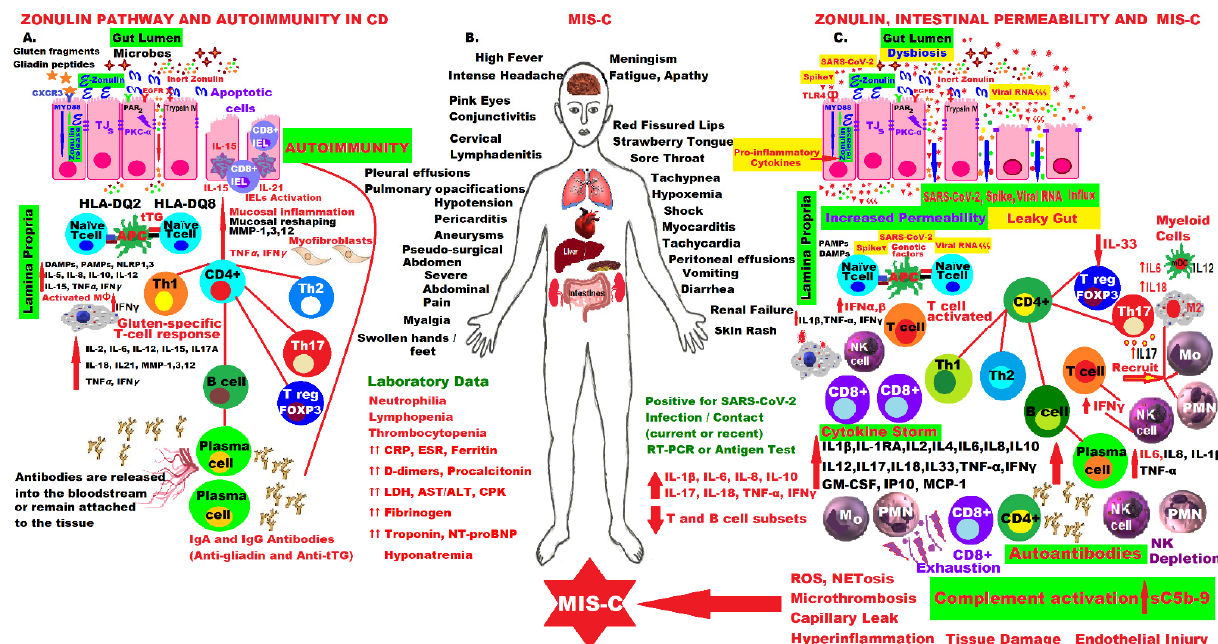
Figure 2. Comparative molecular mechanisms in the pathogenesis of CD and MIS-C by activating the zonulin pathway, increasing intestinal permeability, hyperinflammation and immune dysregulation ( ↑ = Increased; ↑↑ = High). ( A ). The undigested fragments of gluten peptides in the intestinal lamina propria are attacked and deamidated by tTG, then taken up and presented to HLA-DQ2 and DQ8 molecules by DC and via T-helper cells will initiate an adaptive immune response. The gliadin peptides bound to the TLR2 receptors will influence the increase in cytokine production through MYD88, the key protein involved in the release of zonulin after gluten ingestion. The transactivation of zonulin by EGFR through PAR2 stimulates a cascade of biological events that finally will lead to the activation of PKC α -dependent TJs disassembly. Zonulin renders inactive by proteolytic degradation by trypsin IV. Practically, zonulin will weaken the epithelial TJs and increase intestinal permeability. A gluten-specific T-cell response will initiate a cascade of events, followed by the activation of B and plasma B cells, the release of IgA and IgG antibodies (anti-gliadin and anti-tTG), the mucosal inflammation and reshaping, and the initiation of the autoimmune processes. ( B ). Clinical picture and dramatically altered biological data in MIS-C. ( C ). Following the ingestion of the SARS-CoV-2 virus and its presence in the lumen of the small intestine, its spike proteins and RNA fractions, in conjunction with the intestinal dysbiosis, bind to TLR receptors and will influence the increase in pro-inflammatory cytokines production through MYD88, and the release of zonulin, exactly as described above in section A. A zonulin-dependent loss of the intestinal mucosal barrier will lead to a “leaky gut” with subsequent trafficking of SARS-CoV-2 antigens into the bloodstream and a dysfunctional immune response, i.e., immune hyperactivation, massive cytokine production (cytokine storm), huge release of antibodies, complement activation, microthrombosis, severe systemic inflammation, capillary leak, endothelial and tissue damage, and finally multiple organ dysfunction (MIS-C). [Figure 2 was imagined and drawn by L.M.A. using Microsoft Paint 3D (3D Library—Biology: human heart and brain) for Windows 10 and using completely free picture material (human lungs, kidney, intestines, and capillaries clip arts) from SeekPNG.com (accessed